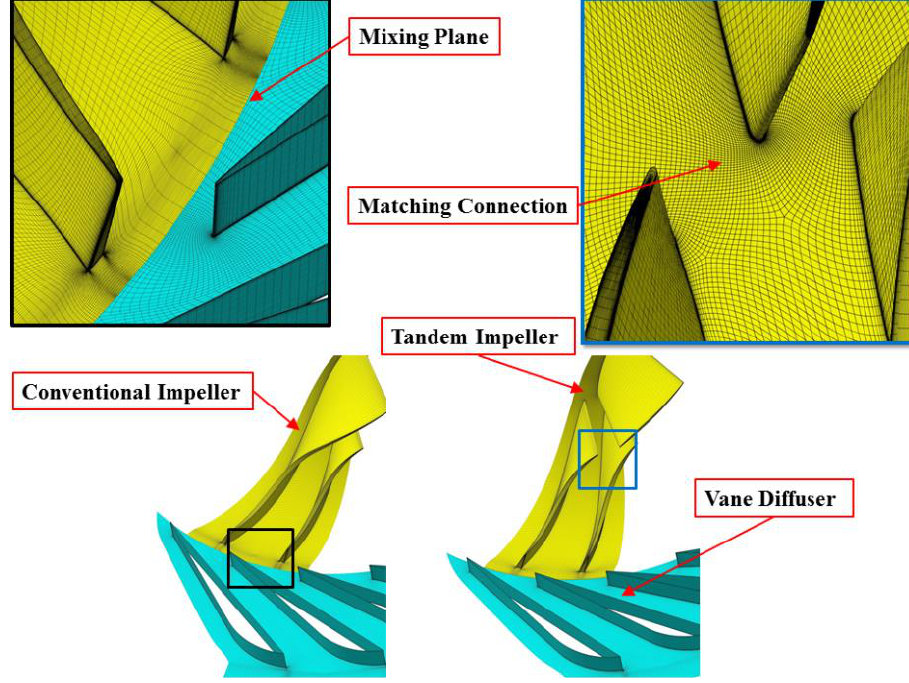
Figure 6. Computational meshes for the conventional and baseline tandem impellers.